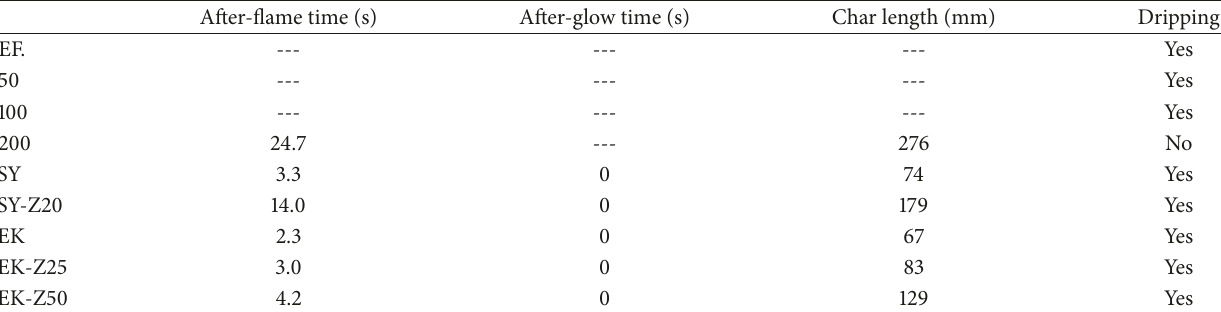
Figure10:Fabricsafterverticalflammabilitytest.(a)Referencefabric;(b)Z50;(c)Z100;(d)Z200;(e)PSY;(f)PSY-Z20;(g)PEK;(h)PEK-Z25; (i) PEK-Z50. Table 7: Vertical flame test results of all fabric